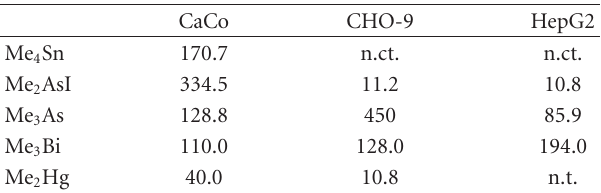
Table 2: LC 50 values of the investigated volatile metal(loid) com- pounds in di ff erent cell lines (exposure time: 1h). Concentrations are given in µmol/L gv . n.ct.: not cytotoxic in the tested concentration range, n.t.: not tested.